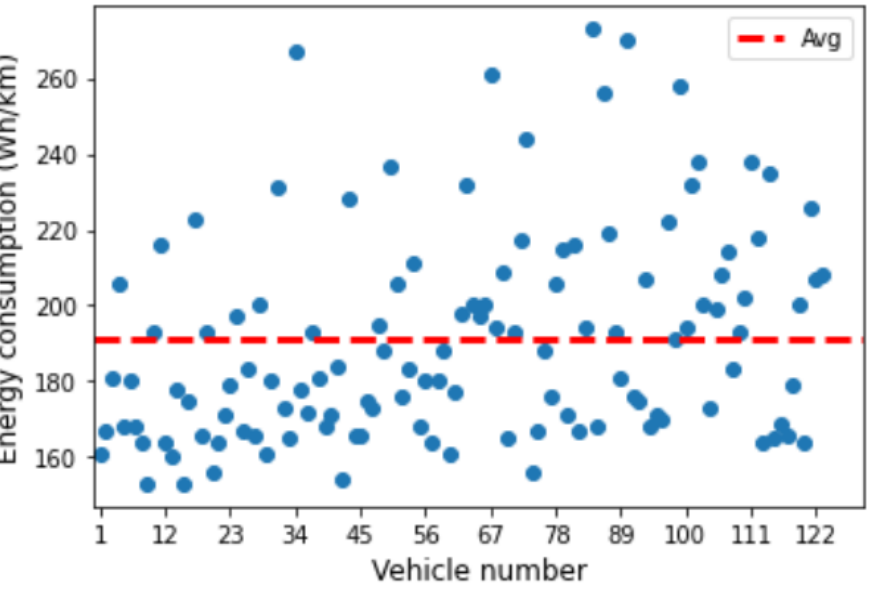
Figure 2. E-vehicle energy consumption (the red line indicates the average value, dots represent each vehicle's record).